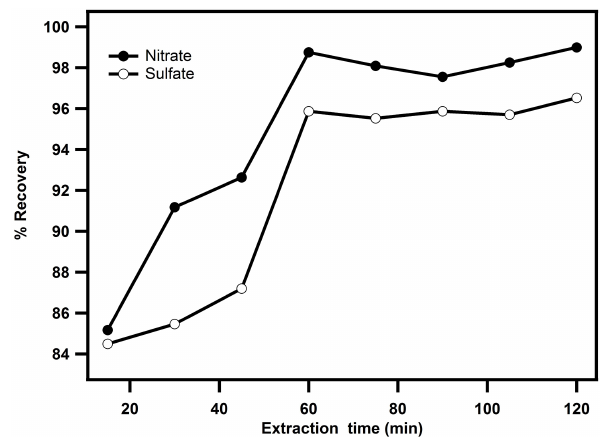
Figure 2. Percent recovery of nitrate and sulfate deposits for dif- ferent sample extraction times. The error bars shown represent the standard deviations of recovery percentage from all five experi- ments at each extraction